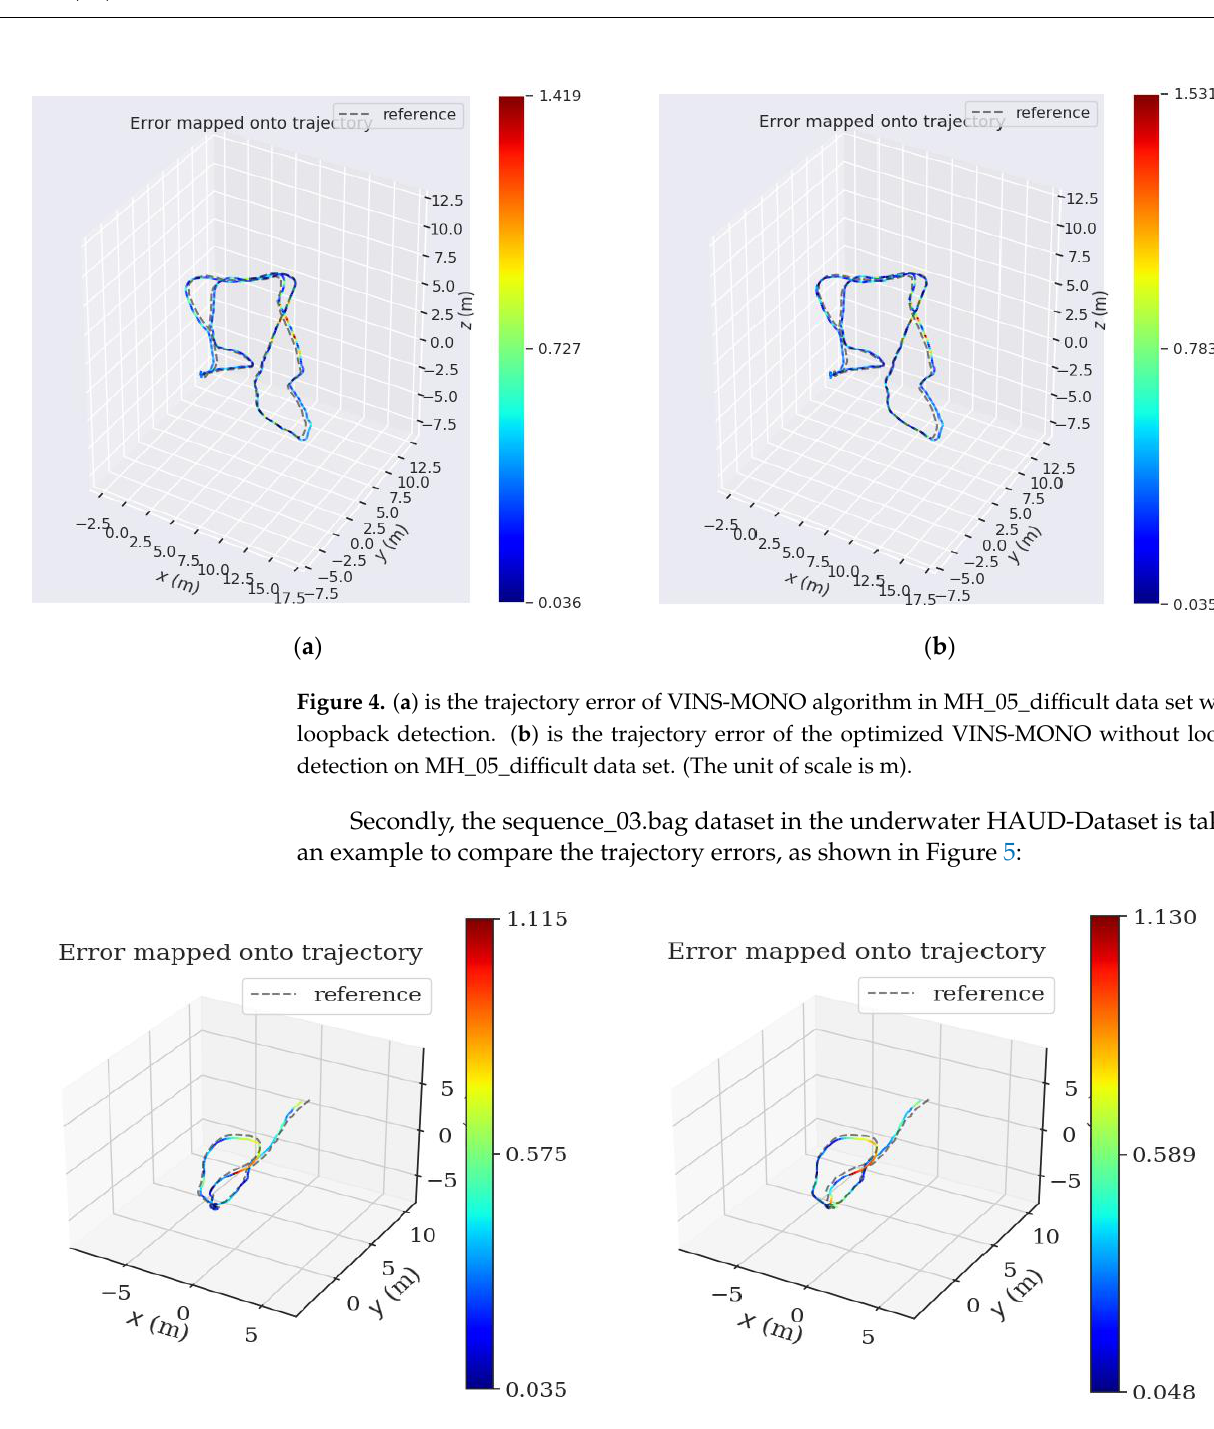
Figure 3. ( a ) is the trajectory error of VINS-MONO algorithm with loop detection on MH_05_diffi- cult data set. ( b ) Trajectory error of loopback detection on MH_05_difficult data set for optimized VINS-MONO. (The unit of scale is m).